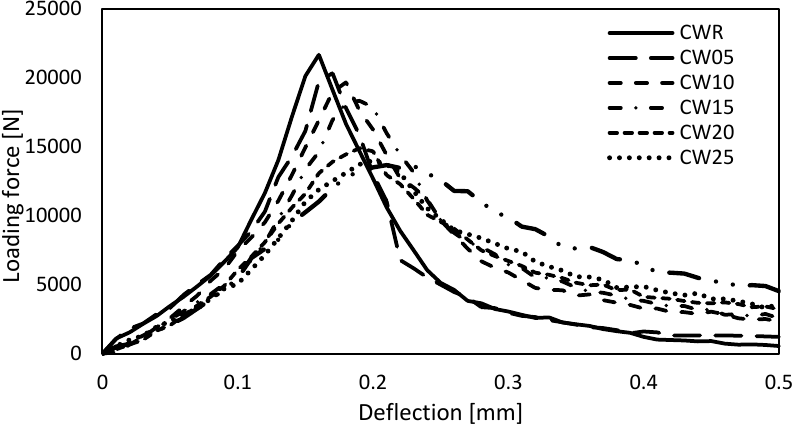
Figure 6. The records of flexural tests after 28 days.